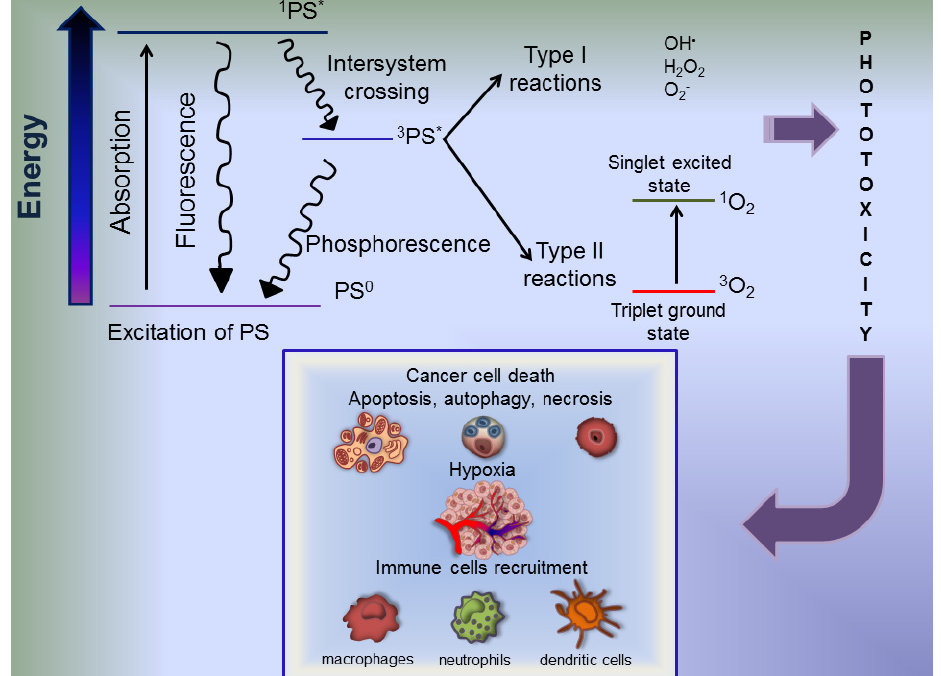
Figure 2. Photophysical and photochemical mechanisms in PhotoDynamic Therapy (PDT) and their effects on tumor. The basis of PDT is the toxic photodynamic reactions induction leading to ROS generation by photochemical and photophysical processes. In the dark, photosensitizers (PSs) exist in the ground state (PS 0 ) with paired electrons; upon absorption of a light photon, one of these electrons shifts to a higher energy orbital, inverts its spin and forms the extremely unstable singlet excited state, 1 PS * , with a half-life ranging between 10 (cid:237) 6 and 10 (cid:237) 9 seconds. The 1 PS * can decay back to the ground state, emitting fluorescence, or undergo intersystem crossing to the longer lived (10 (cid:237) 3 second) triplet excited state ( 3 PS * ), where two electrons are unpaired and have the same spin. 3 PS * may, in turn, decay back to the ground state, emitting phosphorescence or trigger two competing types of photochemical reactions inducing phototoxicity. In type-I photochemical reaction, the 3 PS * reacts directly with cell components transferring an electron or hydrogen to water or biomolecules to form peroxides, superoxide ions and hydroxyl radicals. In type-II photochemical reaction, the 3 PS * mediates the energy transfer process with molecular ) generating a highly toxic activated oxygen molecule, the singlet oxygen oxygen ( 3 O 2 ( 1 O ). In PDT, the in situ generation of 1 O plays a key role in photodynamic cytotoxicity 2 2 because of its efficient interaction with a large variety of biomolecules, such as proteins, nucleic acids and lipids. The cancerous tissue/cells obliteration is ensured by the destructive power of ROS generated upon visible light irradiation of the PS. This result is gained by a multifactorial impact, including direct and indirect effects. In fact, phototoxicity on neoplastic cells occurs via direct tumor cell death by apoptosis and/or autophagy and/or necrosis, damage to the vasculature leading to tumoral area hypoxia and rapid recruitment and activation of immune cells, such as macrophages, neutrophils and dendritic cells. These cells release cytokines amplifying the immune response by activation of B and T cells recruited to the site of